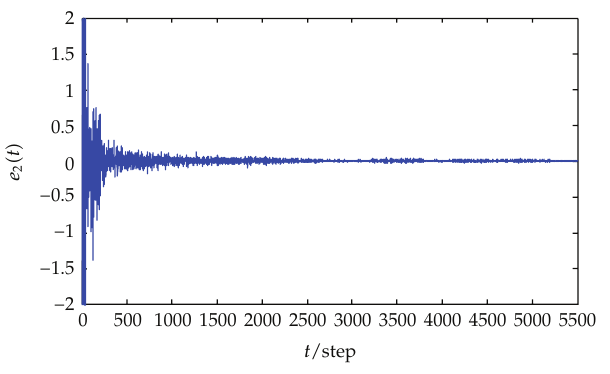
(cid:5) II (cid:6) (cid:5) t | t (cid:6) − (cid:11) x (cid:5) II (cid:6) s (cid:5) t | t (cid:6) for optimal and self-tuning WMF 2 2